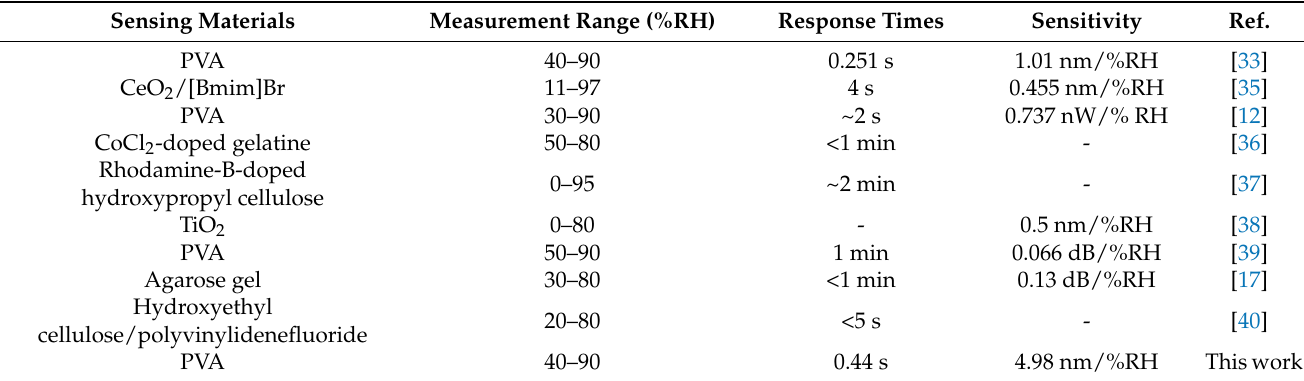
Table 2. Performance comparison of previously reported fiber optics humidity